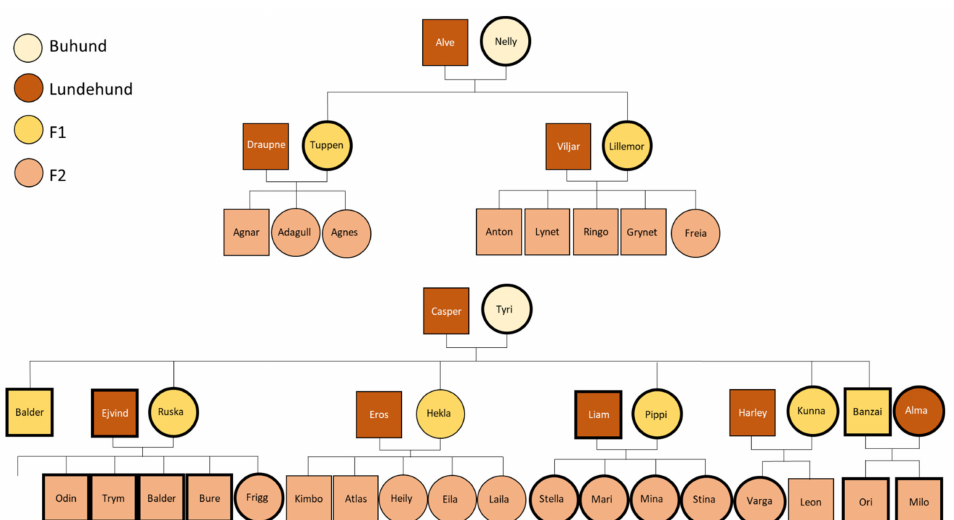
Figure A1. Family trees showing the first two outcrosses of the Lundehund with the Buhund, followed by backcrosses with the Lundehund. Female individuals are represented by circles, and male individuals are represented by squares. The individuals included in these analyses are marked with a thicker outline. The Lundehund and Buhund individuals included in the breeding project were unrelated by pedigree for at least three